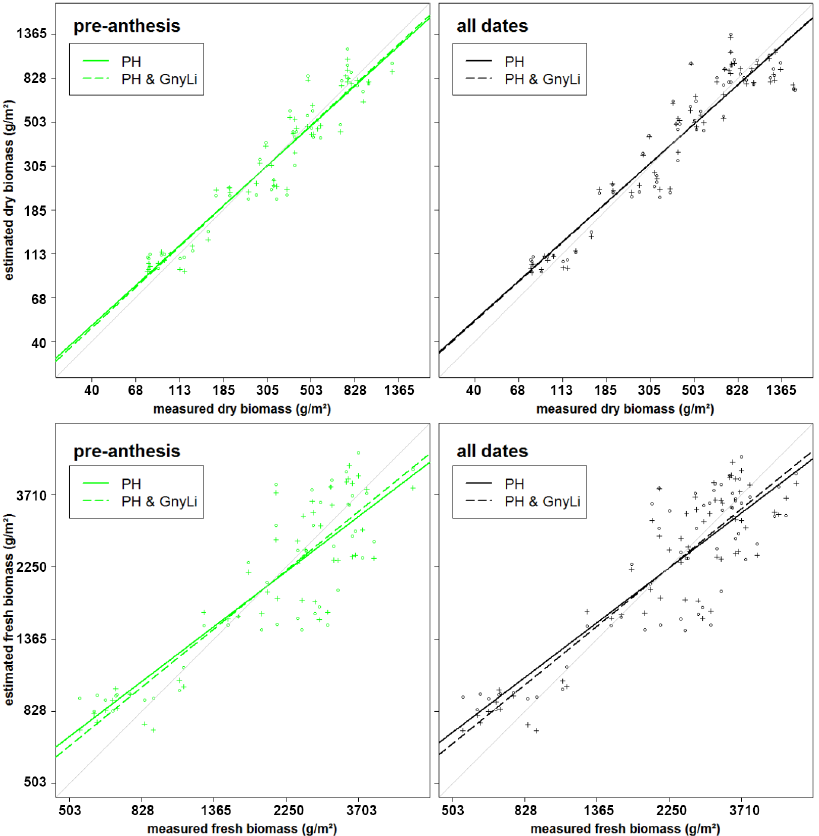
Figure 3. Correction of Figure 7 [1]. Scatterplot for one validation data set for the pre-anthesis (green) and for the whole observed period (black) of the bivariate BRM of PH (circles and solid regression line) and multivariate BRM of PH and GnyLi (crosses and dashed regression line) for fresh biomass (top) and dry biomass (bottom) (all exponential models); 1:1 line: light grey. Reference 1.